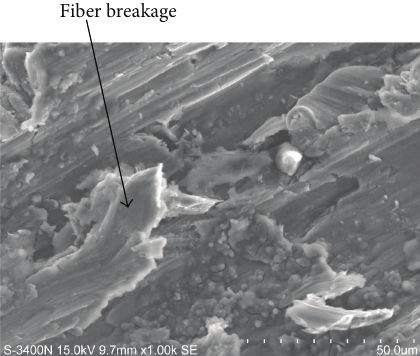
Figure 14: SEM analysis of worn surface of Al + 0% graphite; load- 50